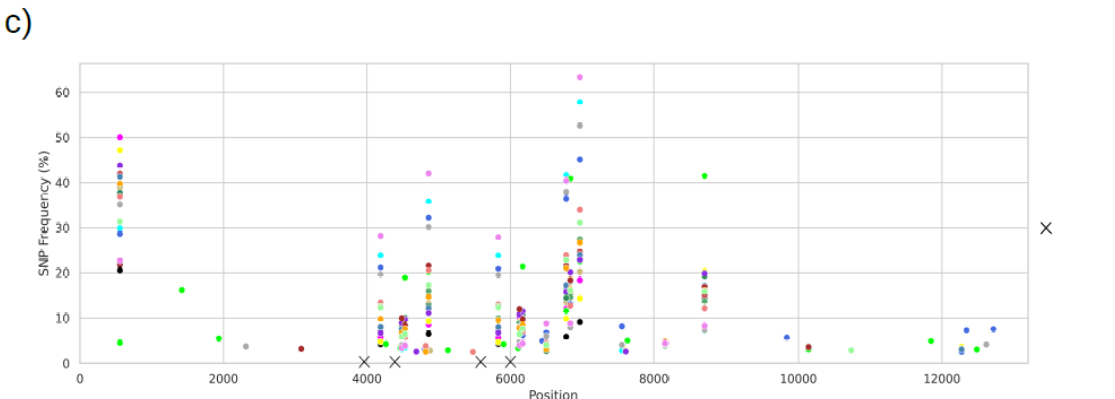
Figure 1. Genomic location of amplicons and variants. ( a ) Genome sequence of Rabies lyssavirus SPBN GASGAS strain and primer pairs used to generate amplicons (f — forward, r — reverse primer). The amplicons generated are indicated above according to numbering in Table 1. ( b ) Whole-genome read coverage for pooled 5th SMB passage (P5) sample and 17 SMB samples from passage 6 (MxKx— animal number). ( c ) SNP frequency in P5 and 17 individual SMB samples from passage 6. Positions, in which a change in consensus sequence occurred in at least one sample, are indicated above the given position together with the nucleotide and amino acid changes. The mutation introduced in SPBN GAGSAS strain, namely AAT [Asn] → TCC [Ser] (aa position 194) and AGA [Arg] → GAG [Glu] (aa position 333) are indicated by highlighting the middle nucleotide with “ ×